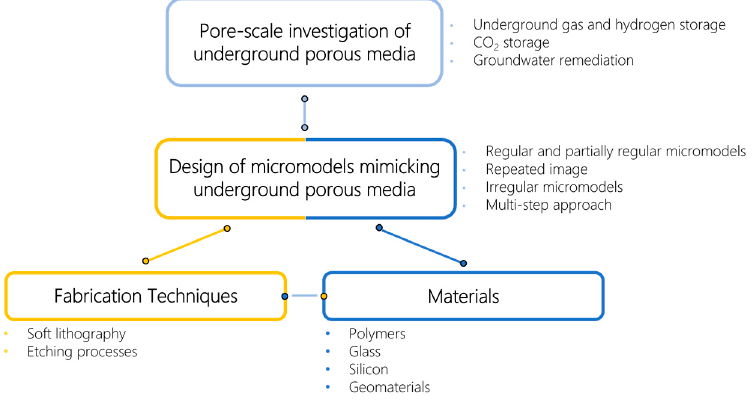
Figure 3. Design and fabrication work fl ow of micromodels for the investigation of pore-scale